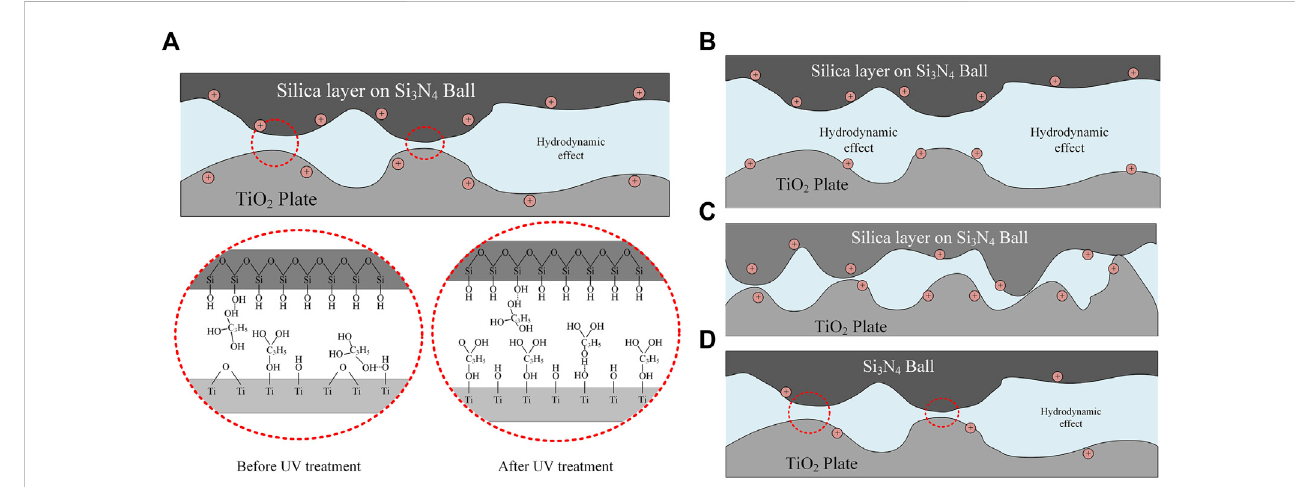
FIGURE 12 (A) Mechanism of photoinduced superlubricity. The failure mechanism of photoinduced superlubricity: (B) fi lm thickness was large enough to separate two friction surfaces and the elastohydrodynamic effect dominated; (C) fi lm thickness was low and the boundary lubrication dominated; (D) silica layer had not been formed and adsorption of hydrogen ions and glycerol molecules was not enough to separate the two friction